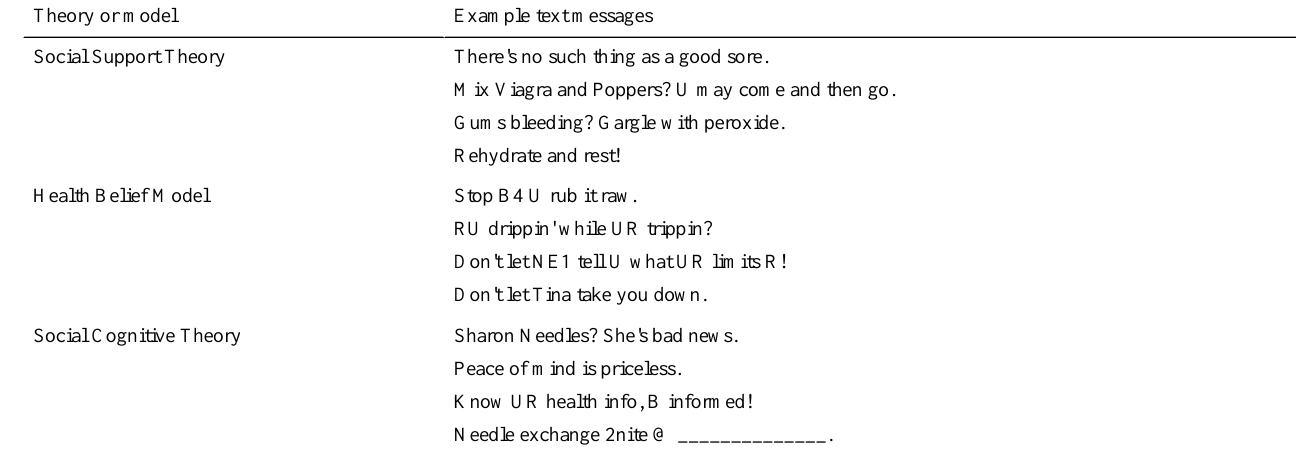
Table 1. Example text messages shared for feedback during formative work.